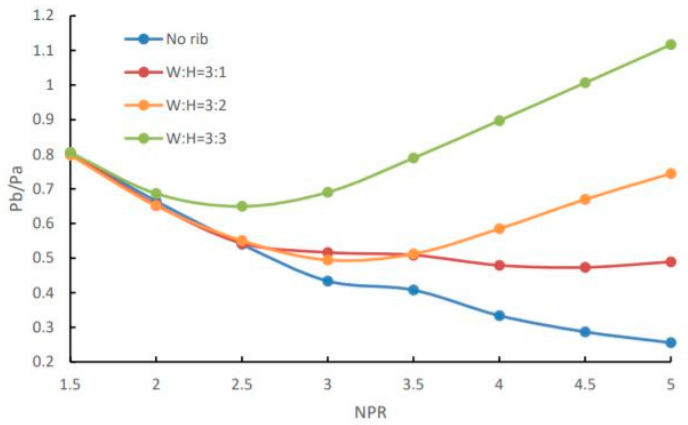
Figure 9. Base pressure changes when NPR is increased from 1.5 to 5, and the aspect ratio is changed from 3:1 to 3:3 [18]. from 3:1 to 3:3